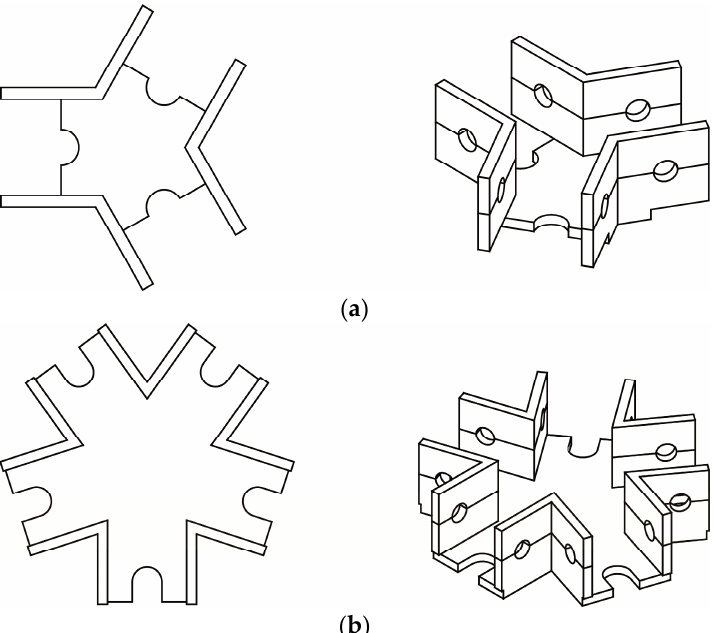
Figure 9. Plan view and 3D view of the base of novel joints with bevel gears: ( a ) Connected to three link members; ( b ) connected to five link members.